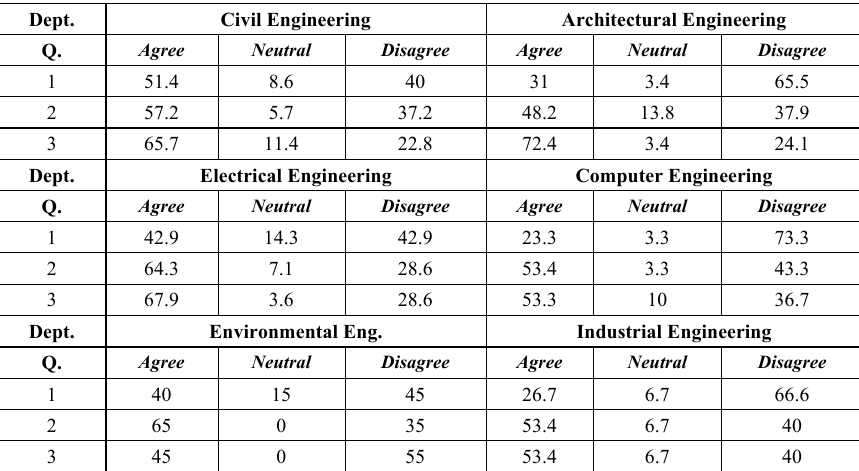
Table 1. Students’ responses to the questions of Questionnaire B presented for the